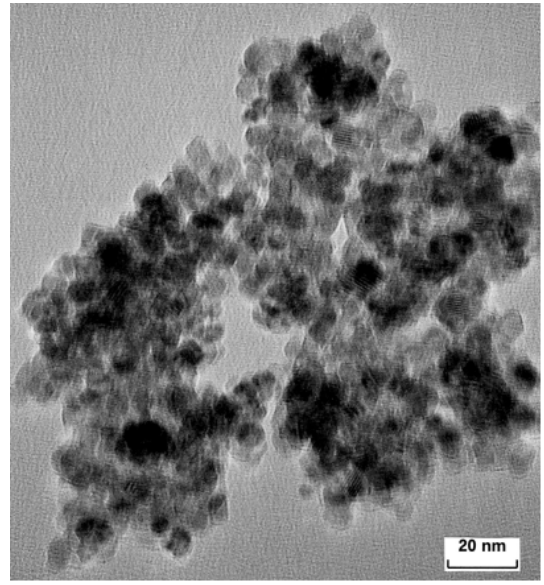
Figure 4. TEM image of 7.7 wt. % Co/CeO 2 (hp) catalyst.